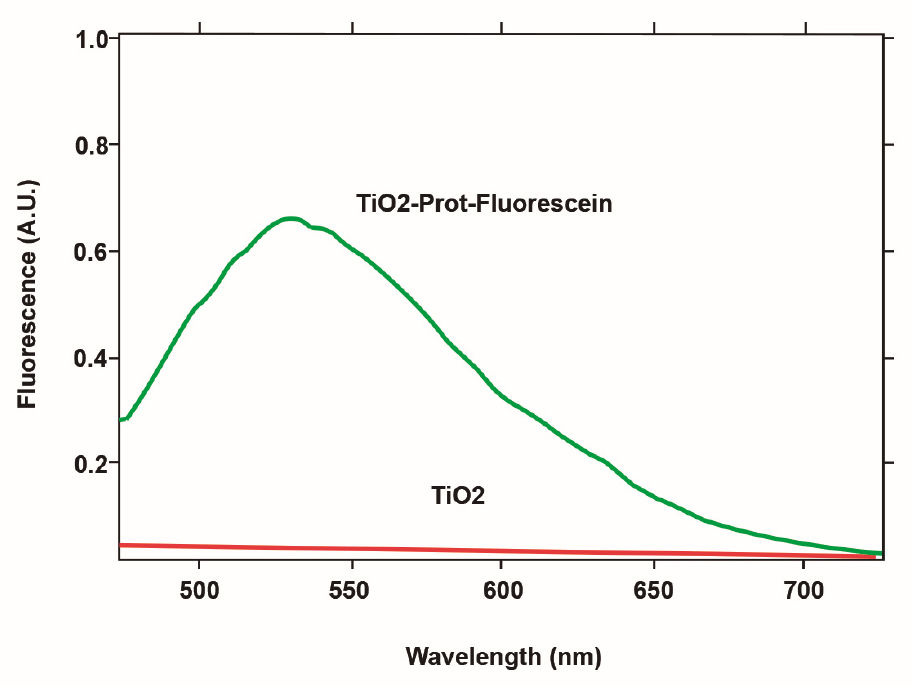
Figure 6. Fluorescence emission spectrum of the protein monolayer on a TiO 2 surface—the red line indicates the absence of fluorescence when there is no protein on the surface.